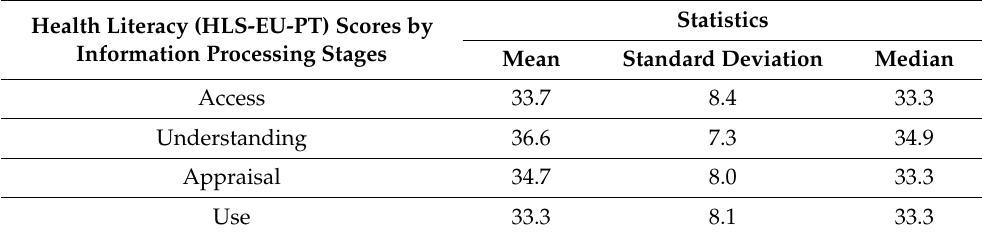
Table 3. Characterization of Caregivers’ Health Literacy distribution by information processing stages.